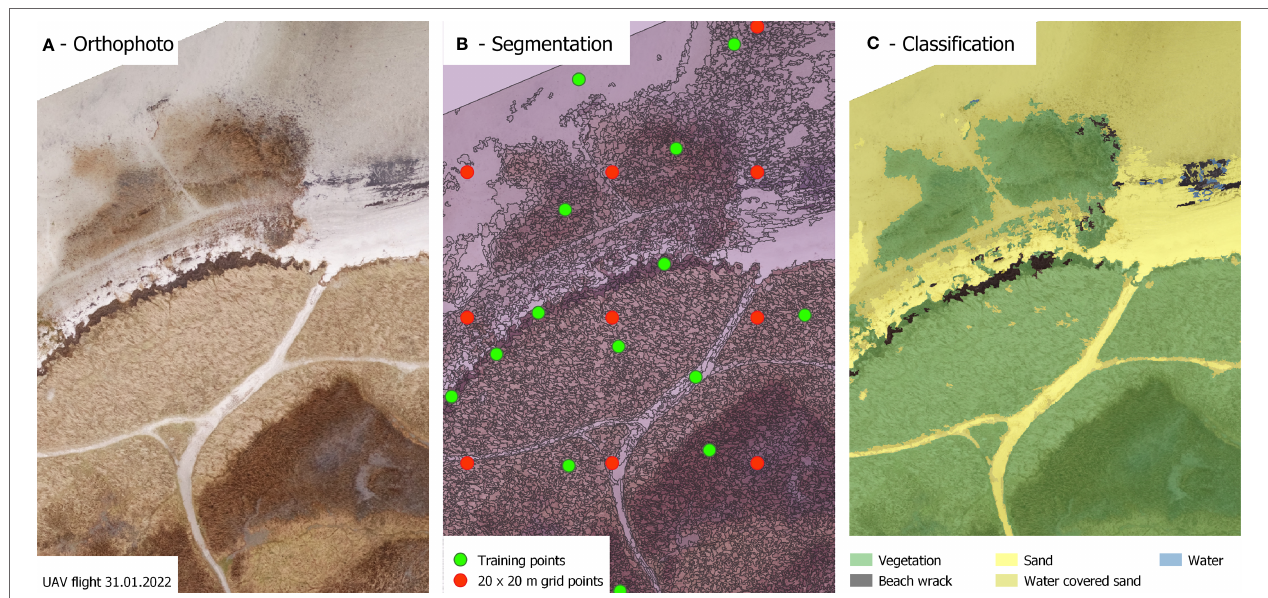
FIGURE 2 | Data from UAV overflight in 70 m height. (A) Orthophoto showing unvegetated and vegetated beach with some beach wrack in the transition zone. (B) OTB segmentation results including training points for 5 classes as well as 20 × 20 m regular square grid of points for accuracy assessment. (C) Final classification results.